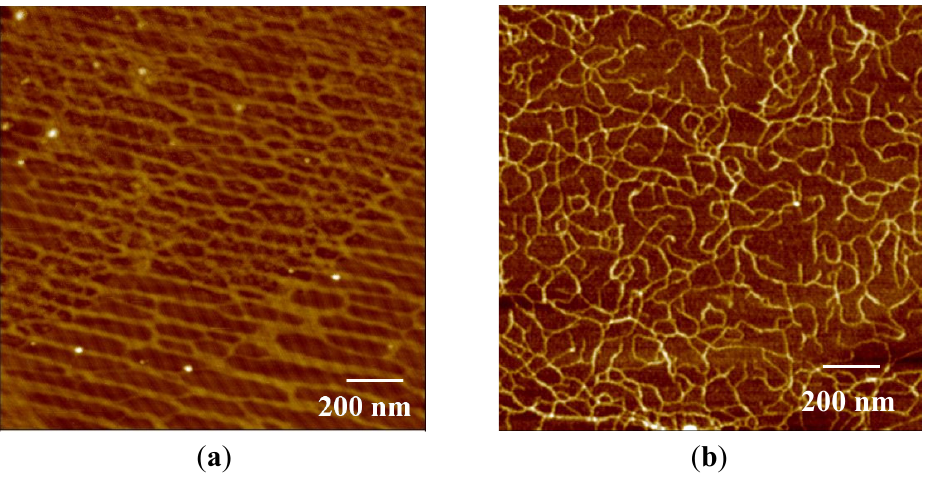
At room temperature, this (1 → 3)(1 → 2)- β - D -Glucan forms a gel network structure, that we probed by TM-AFM, Figure 2a. Figure 2. TM-AFM height images of: ( a ) (1 → 3)(1 → 2)- β - D -Glucan; ( b ) scleroglucan. Images were obtained by depositing the glucans from 10 mg/L aqueous solutions onto mica and scanning in air. Height images of 1.5 μ m × 1.5 μ